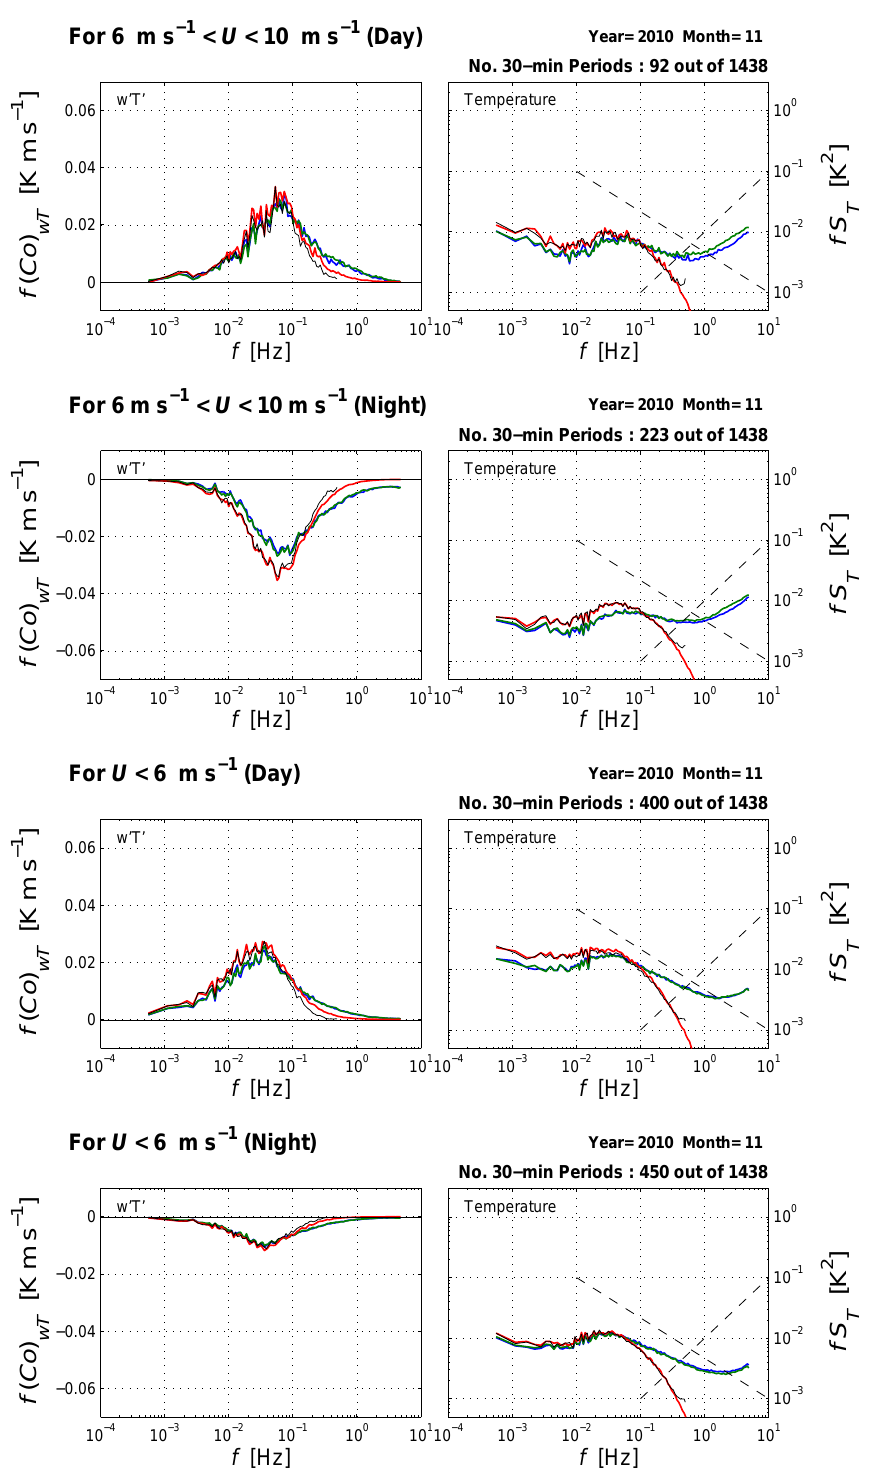
Fig. 4. The (left column) w 0 T 0 cospectra (Co) wT and (right column) temperature spectra S T for medium- and low-wind conditions (see Fig. 3 for the legend and further